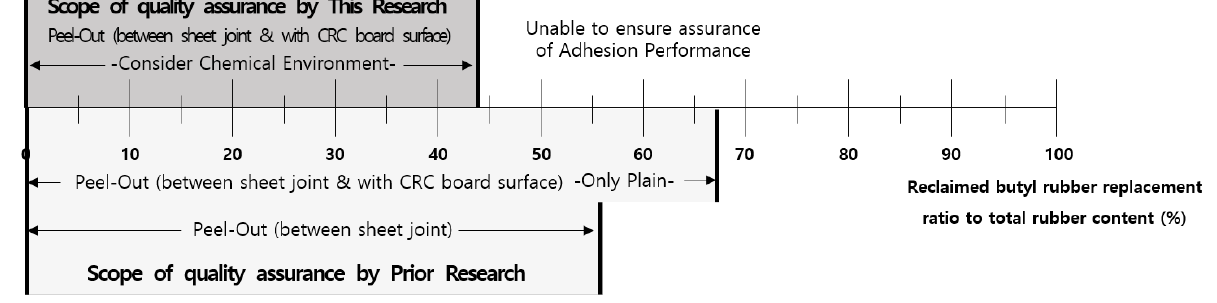
Figure 15. Result of the quality assurance.